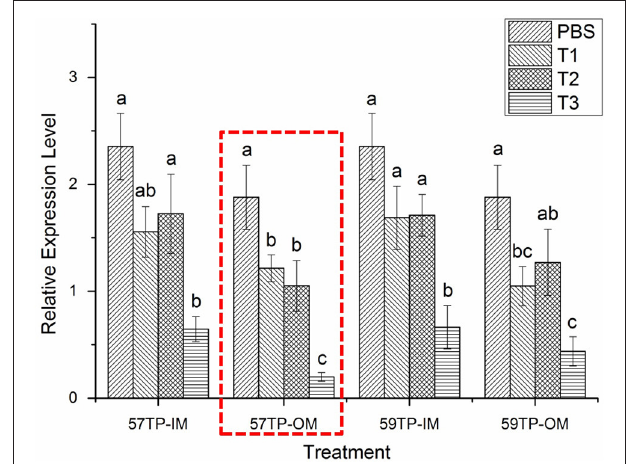
FIGURE 4 | The mRNA expression levels of CGI_10012534 gene in the in-mantle and out-mantle of oysters after RNAi. Notably, 57TP-IM indicates the siRNA-57 targeted treatment group in the in-mantle, 57TP-OM indicates the siRNA-57 targeted treatment group in the out-mantle, 59TP-IM indicates the siRNA-59 targeted treatment group in the in-mantle, 59TP-OM indicates the siRNA-59 targeted treatment group in the out-mantle, PBS indicates the group treated with PBS ( n = 6), T1 indicates the group treated with 5 µ g/100 µ l siRNA ( n = 6), T2 indicates the group treated with 10 µ g/100 µ l siRNA ( n = 6), and T3 indicates the group treated with 15 µ g/100 µ l siRNA ( n = 6). Each bar represents the mean of six independent experiments. Different letters indicate a significant difference ( P < 0.05).